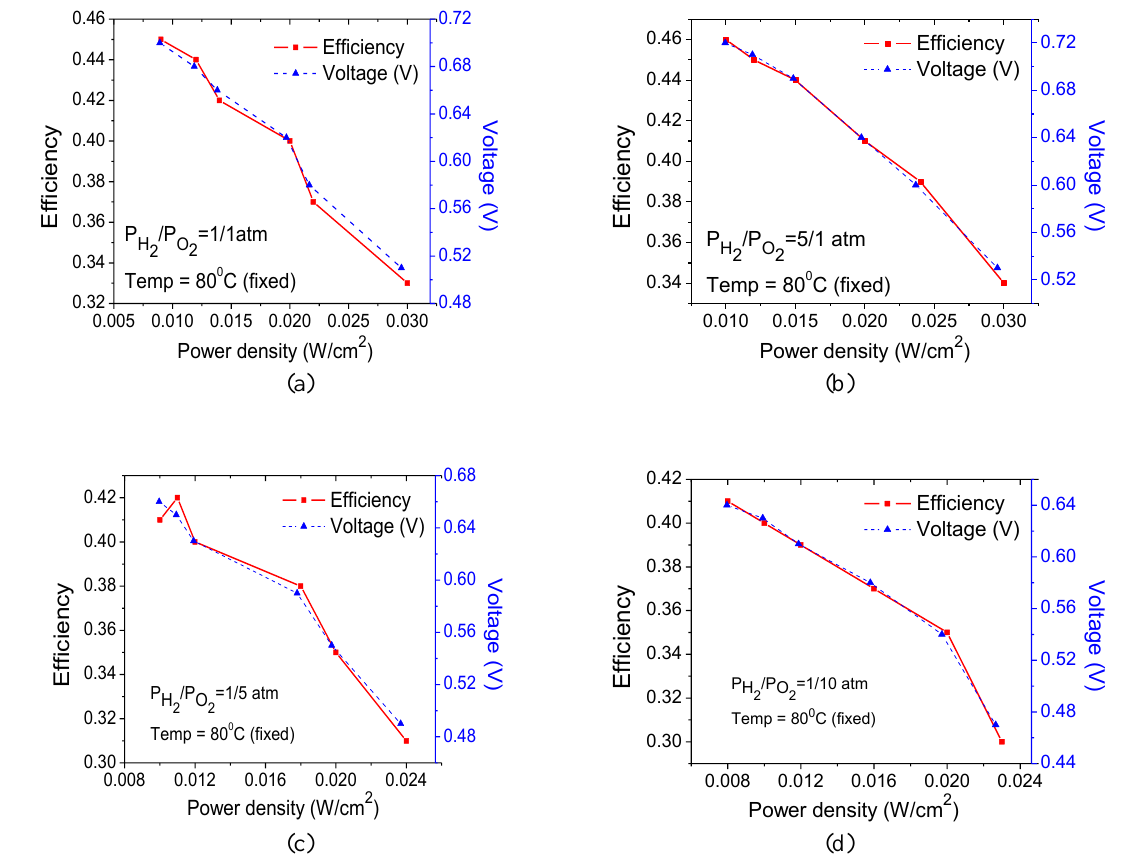
Figure 1. (a)-(d). Efficiency, power density and voltage at constant temperature and reactants flow pressure